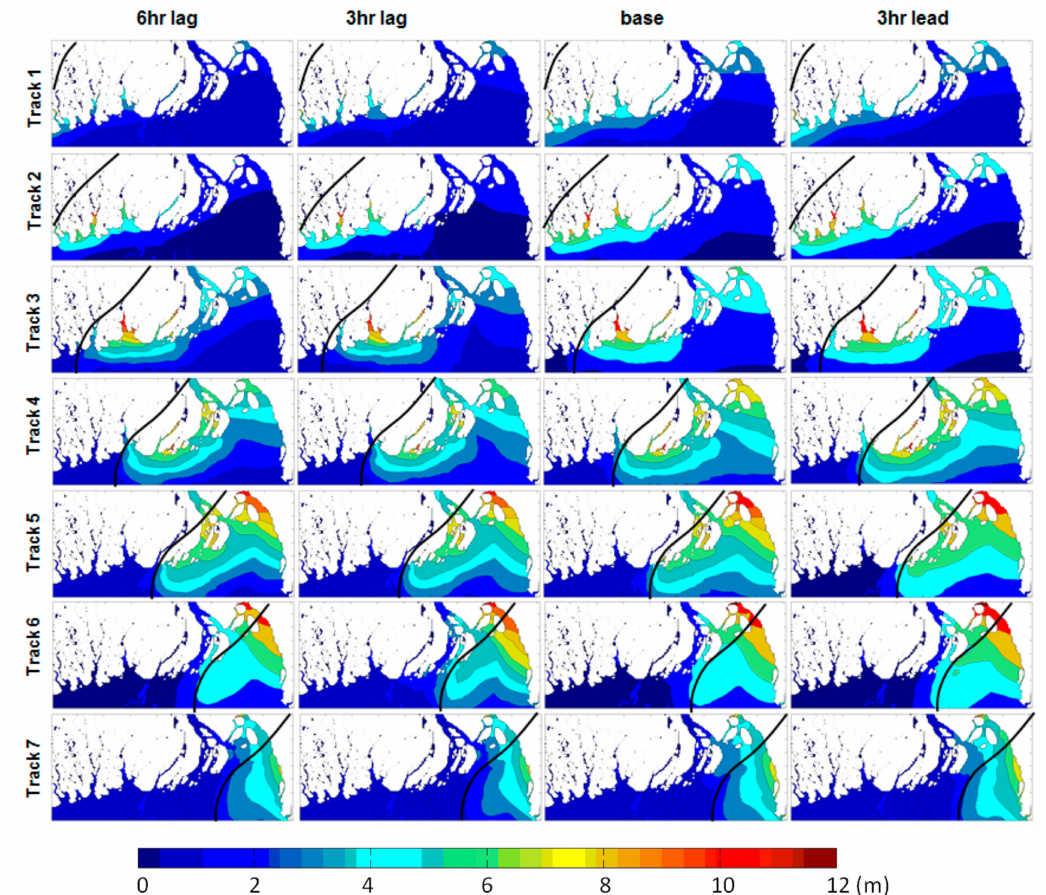
Figure 12. Spatial distribution of maximum surge height (m) at different tidal phases for Tracks